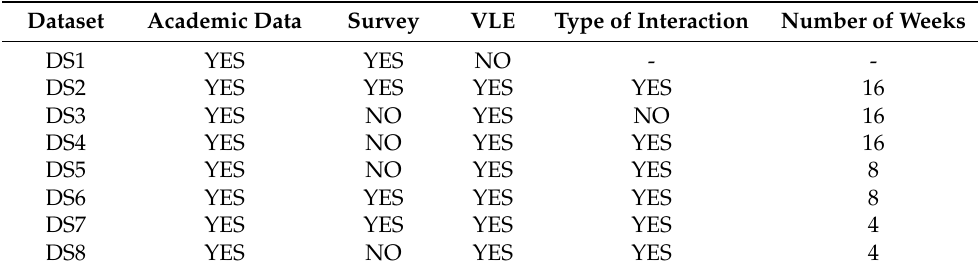
Table 4. Configuration of the different